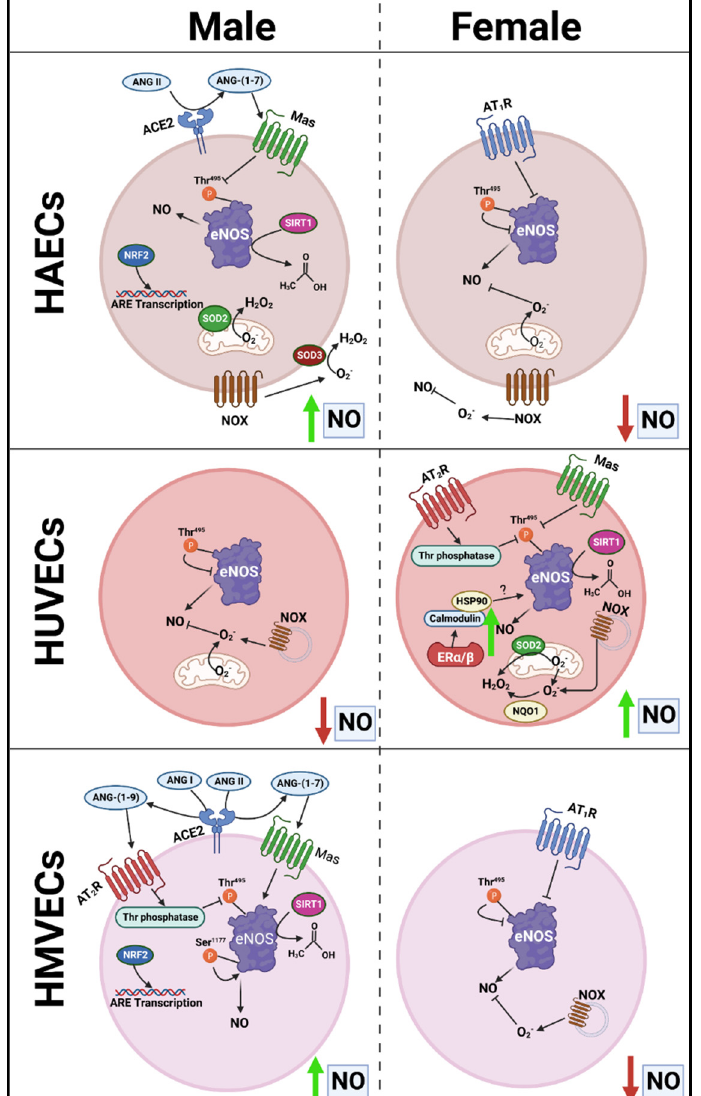
Figure 12. Proposed schematic presentation of sex-specific differences in protein expression between endothelial cells that may mediate sex- and cell-specific discrepancies in NO bioavailability. The source of ROS generation in the three types of human primary endothelial cells used in the present investigation cannot be explained by differences in NOX2, NOX4, and